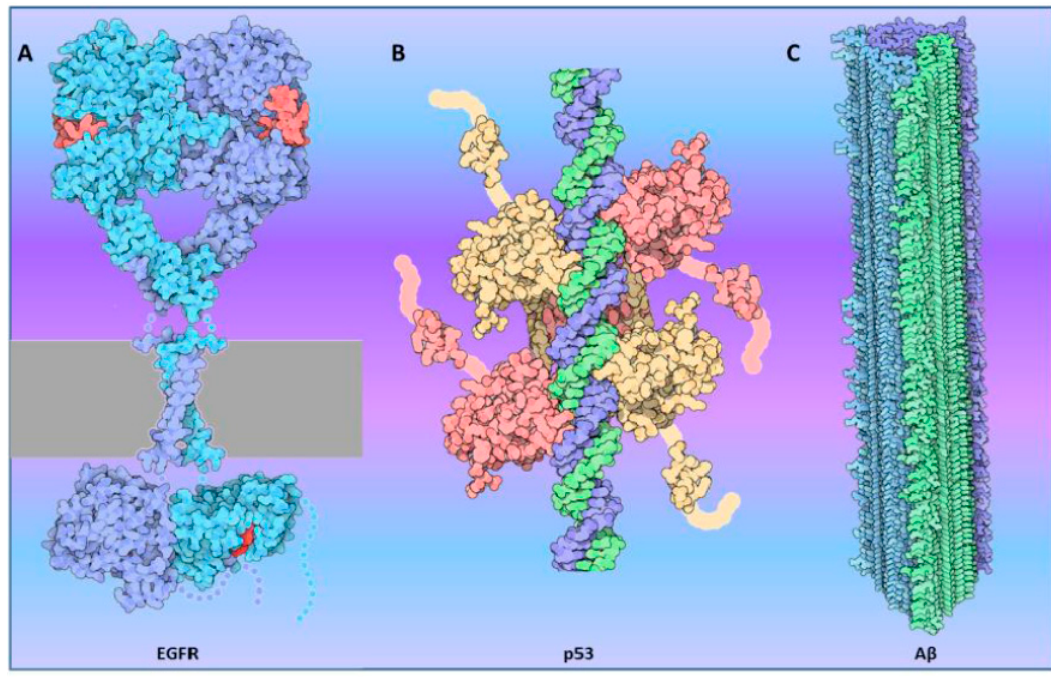
Figure 1. Examples of oligmerization in active proteins: ( A ) Epidermal Growth Factor Receptor (EGFR, shown in light blue and purple) dimerizes in the plasma membrane (represented in gray). Binding of the hormone (in red) triggers activation of the intracellular kinase domain (constructed from PDB entry 2gs6); ( B ) p53 binds to the DNA (blue/green) as a tetramer (shown in pink/yellow) (constructed from PDB entries 1tup , 1olg and 1ycq) ; ( C ) A β (1–42) forms fibrils that can accumulate in the brain causing neurodegenerative disorders including Alzheimer’s disease. Three different β -sheet stacks (colored in green, blue and purple) form the amyloid fibril (constructed from PDB entry 2m4j). These examples were “molecules of the month” on the RCSB PDB, generated by David S. Goodsell [17].